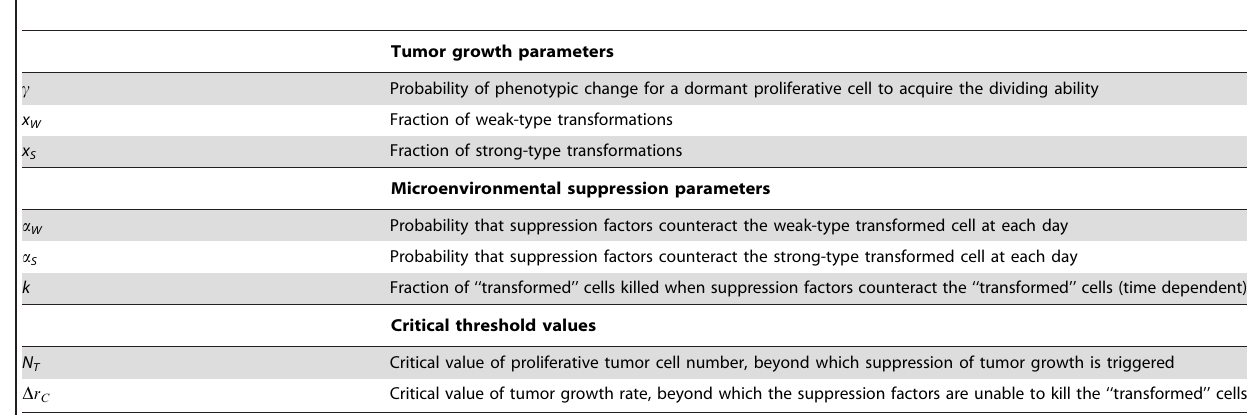
Table 1. Parameters characterizing the interactions between tumor suppression factors and tumor cells in the CA dormancy